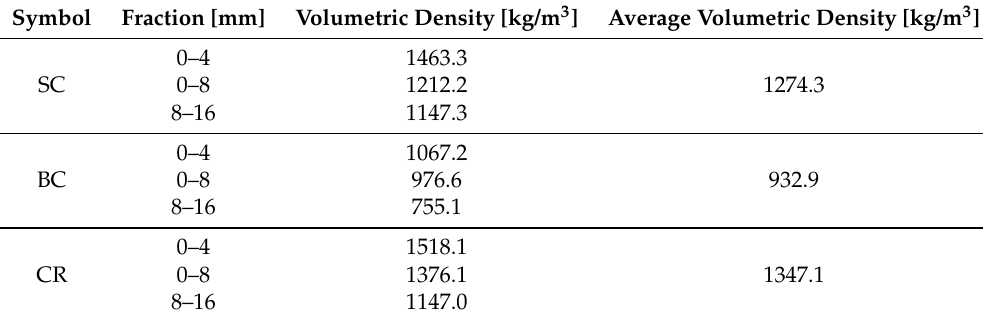
Table 1. Volumetric density of the used aggregates.